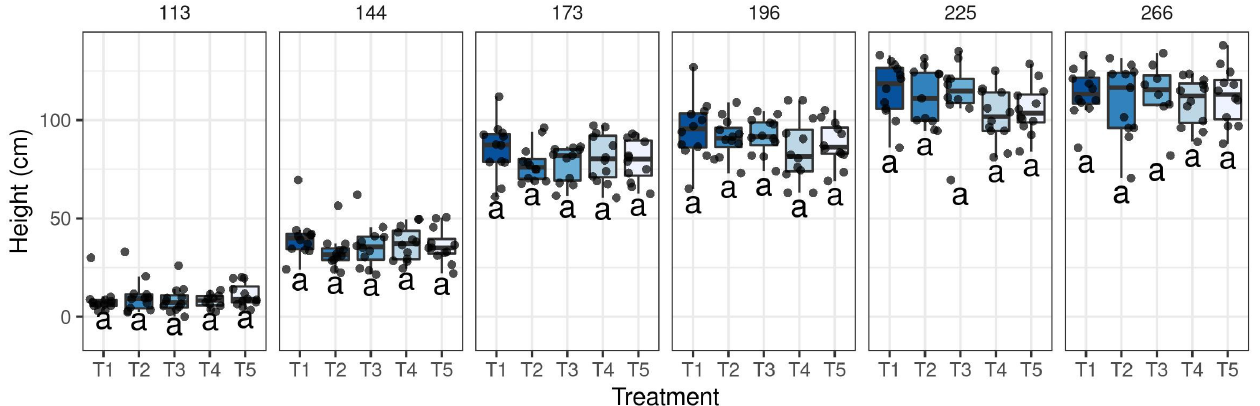
Figure 1. Boxplot of raspberry Himbo Top plant height depending on substrate and DOY. T1 = Commercial Peat (P) 90% + Compost A (CA) 10%; T2 = P 80% + CA 20%; T3 = P 60% + CA 40%; T4 = Commercial Peat (P) 100%; T5 = P Commercial Peat 100% + Osmocote. Different letters indicate statistically significant differences after ANOVA and Duncan post-hoc test at p -value < 0.05.